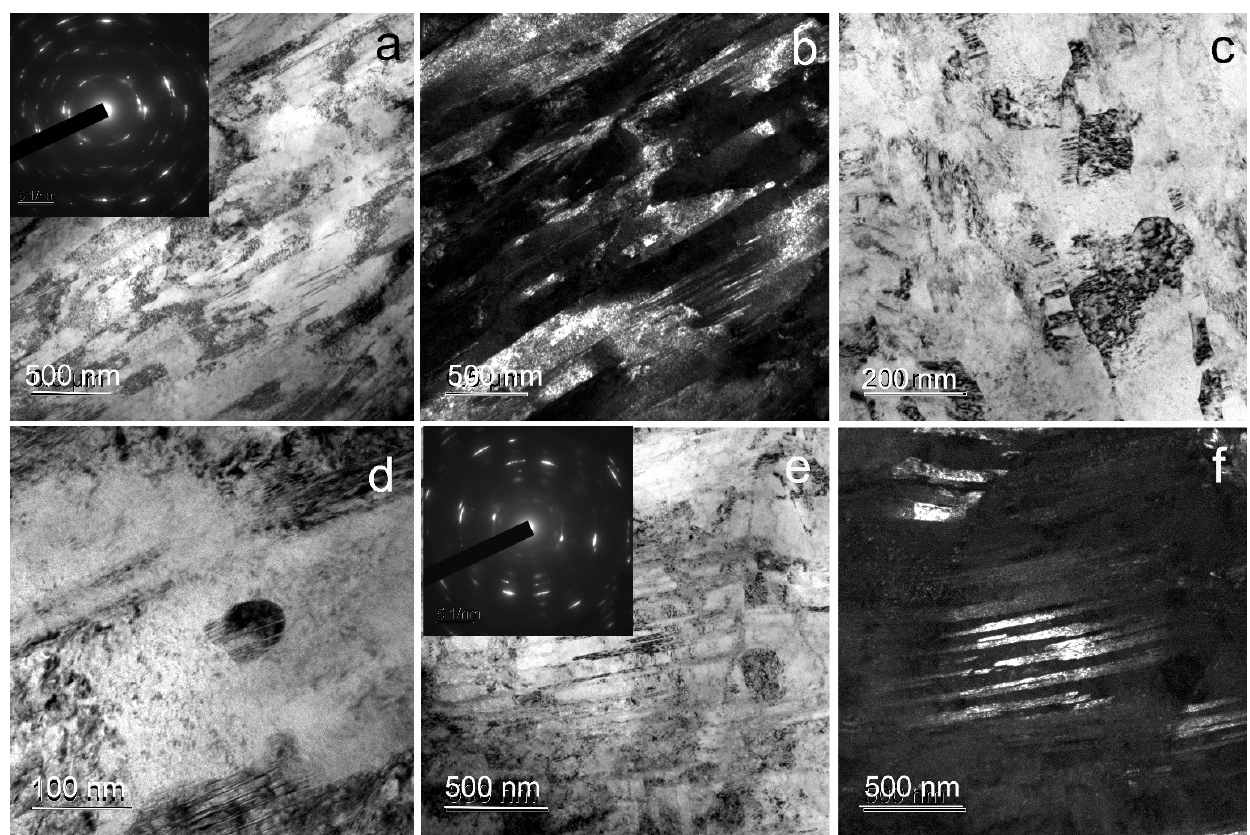
Figure 4. TEM images of Fe-Mn-Pd alloy after ECAP at 300 °C: ( a , c , d ) BF image of subgrain area with SAED pattern can be seen in the inset ( a ); ( b ) DF image of subgrain area; ( e ) BF image of twins area with SAED pattern can be seen in the inset; ( f ) DF image of twins area. During ECAP at 450 °C, two types of UFG structures are also formed in shear bands 211 ± 35 nm thick (Figure 5). Some areas are twins in austenite 24 ± 1 nm thick crossing shear bands (Figure 5a).